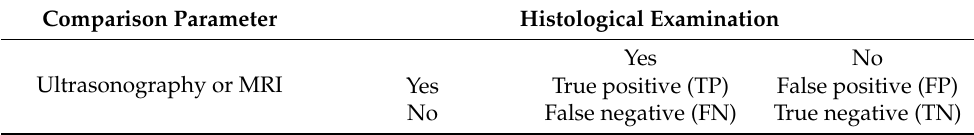
Table 1. Confusion matrix template. Comparison